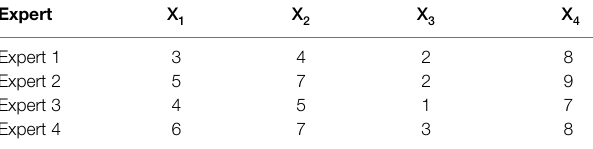
TABLE 6 | Assessment of the importance of indexes–entropy weight method. Expert X